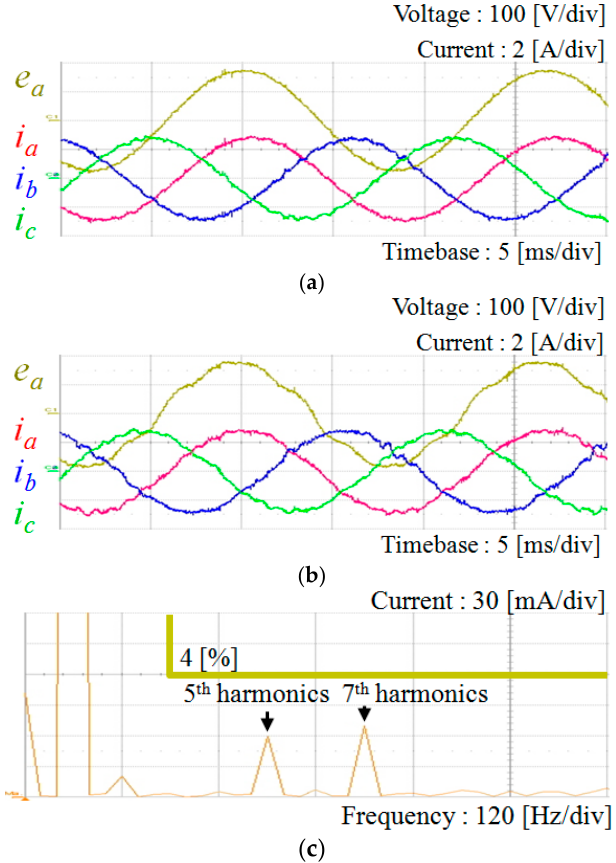
Figure 18. Experimental results for inverter output currents of the proposed voltage-sensorless control scheme under distorted grid condition. ( a ) Under unbalanced grid voltages; ( b ) under harmonic distorted grid voltages; and ( c ) FFT result for a -phase current in ( b ).